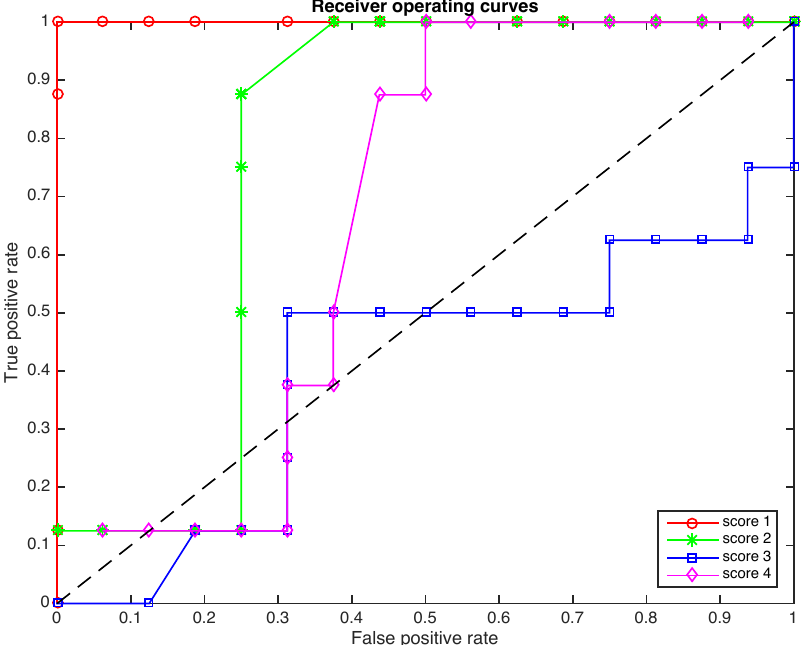
Figure 7. The Receiver Operating Curves (ROCs) for the four scores when the size of the samples to diagnose is ν =